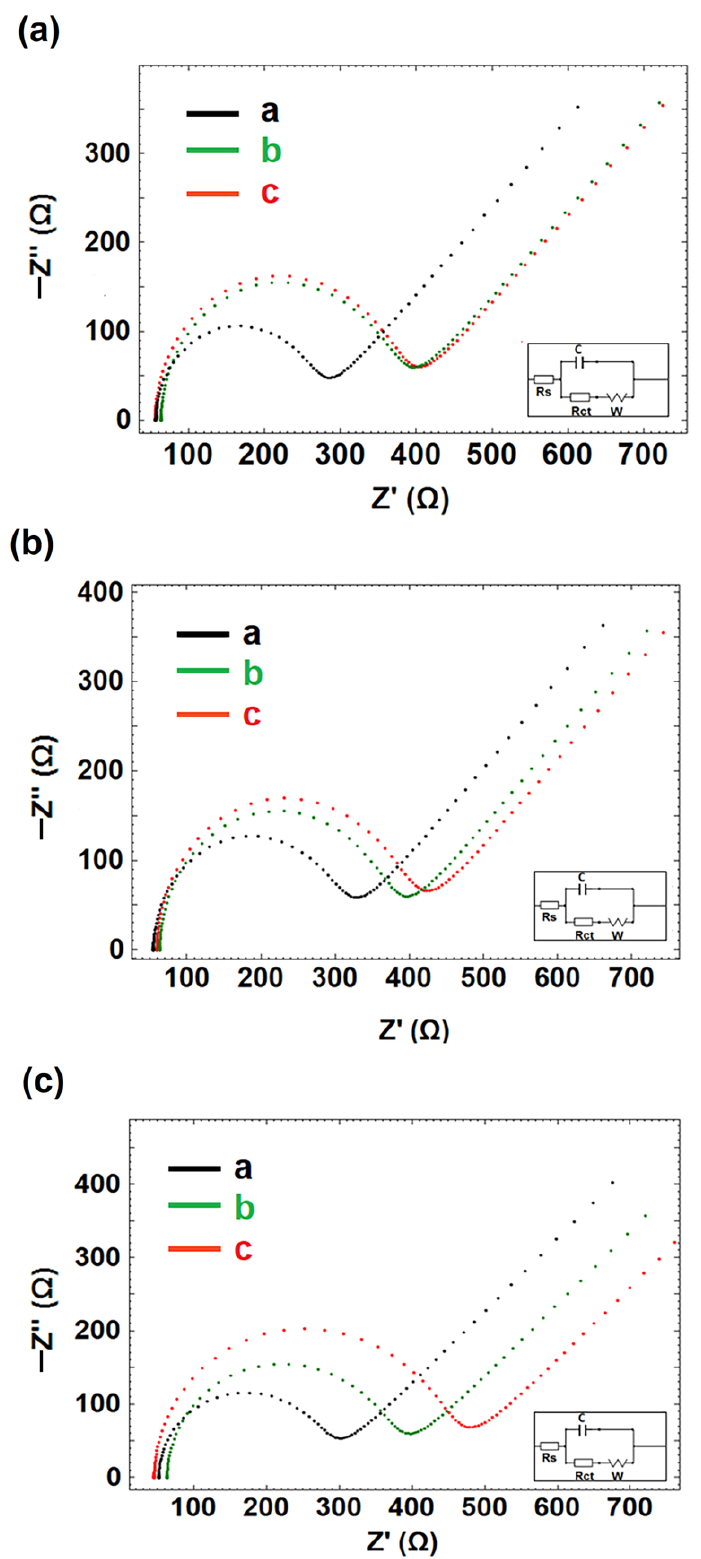
( b ) 0.01 µ g/mL DNA-Apt ( c ) 0.1 µ g/mL DNA-Apt, the Niquist curves obtained in redox solution: Figure 4. In the presence and absence of 0.2 μg/mL APC with ( a ) 0.005 μg/mL DNA - Apt, ( b ) 0.01 (a) DNA-Apt/CNF-IL/PGE, (b) APC/CNF-IL/PGE, (c) μg/mL DNA - Apt ( c ) 0.1 μg/mL DNA - Apt, the Niquist curves obtained in redox solution: (a) DNA - Apt/CNF - IL/PGE, (b) APC/CNF - IL/PGE, (c) APC/DNA - Apt/CNF - IL/PGE.